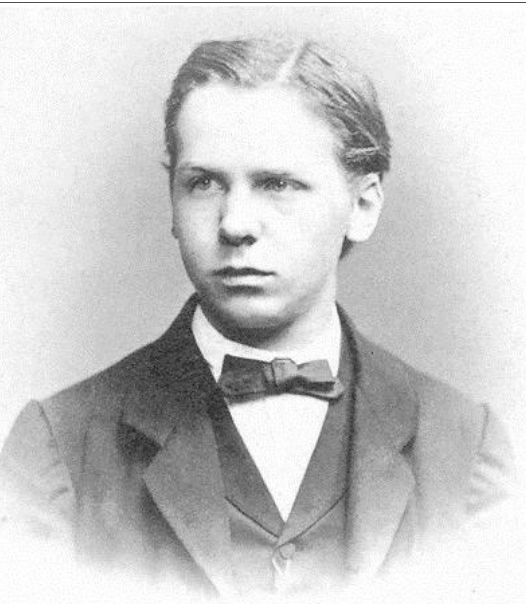
Figure 1. Paul Langerhans (25 July 1847 – 20 July 1888)